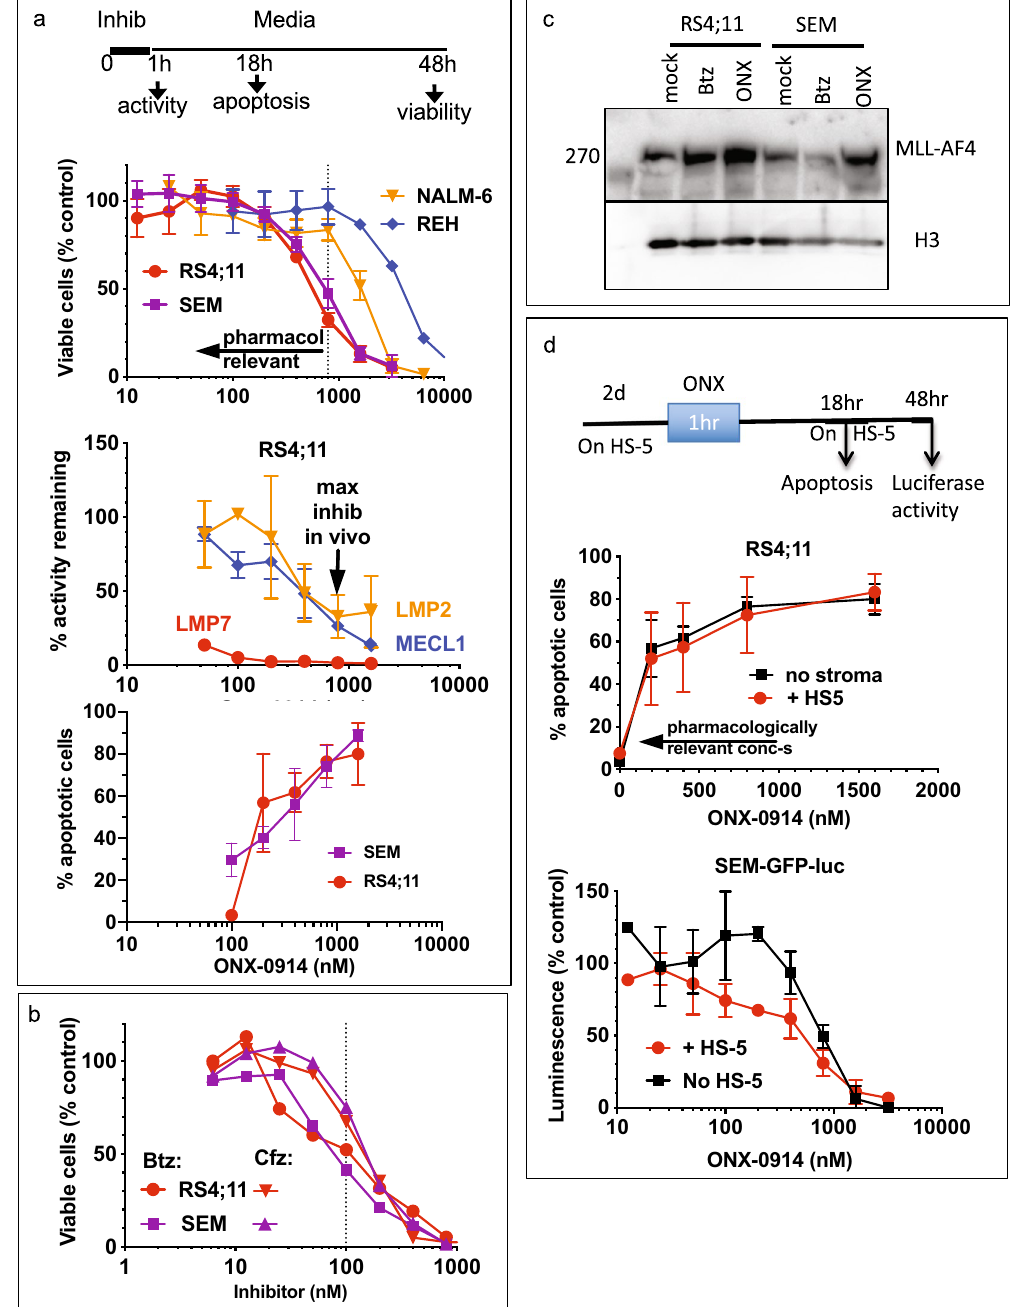
Figure 2. MLL–AF4 cell lines are sensitive to pharmacologically relevant concentrations of ONX-0914. ( a ) Cells were treated with ONX-0914 for 1 h and cultured for 2 days before assessing cell viability with Alamar Blue (top panel, n = 7, SEM and RS4;11; n = 2, other), or cultured for 17 h before measuring apoptosis (bottom panel, n = 2, SEM; n = 3, RS4;11). Alternatively, cells were harvested for activity measurements immediately after 1 h treatment (middle panel, n = 2), LMP7 and LMP2 activity was measured with fluorogenic substrates, MECL1 inhibition was determined using BODIPY(TMR)-NC-005 probe. Arrows and dashed lines indicate pharmacologically relevant concentrations. ( b ) Cells were treated with Btz or Cfz for 1 h and cultured for 2 days before assessing cell viability with Alamar Blue (n = 2). ( c ) Cells were treated with 10 nM Btz or 800 nM ONX- 0914 for 4 h. MLL–AF4 expression was analyzed by western using histone H3 as a loading control. Uncropped images of the blot are presented on Fig. S3. ( d ) RS4;11 or SEM-GFP-luc cells were cultured with HS-5 stromal cells for 48 h, treated with ONX-0914 for 1 h in the absence of HS-5, and then cultured with HS-5 cells for the times indicated. Apoptosis of RS4;11 cells was measured by flow-cytometry (top panel, n = 3). Size-based gating was used to distinguish between RS4;11 and HS-5 cells (see Fig. S4). Luciferase assay was performed to access viability of luciferase-expressing SEM-GFP-luc cells (n = 2). Bottom panel in ( a ) and top panel in ( d ) contain the same data for RS4;11 cells treated in the absence of